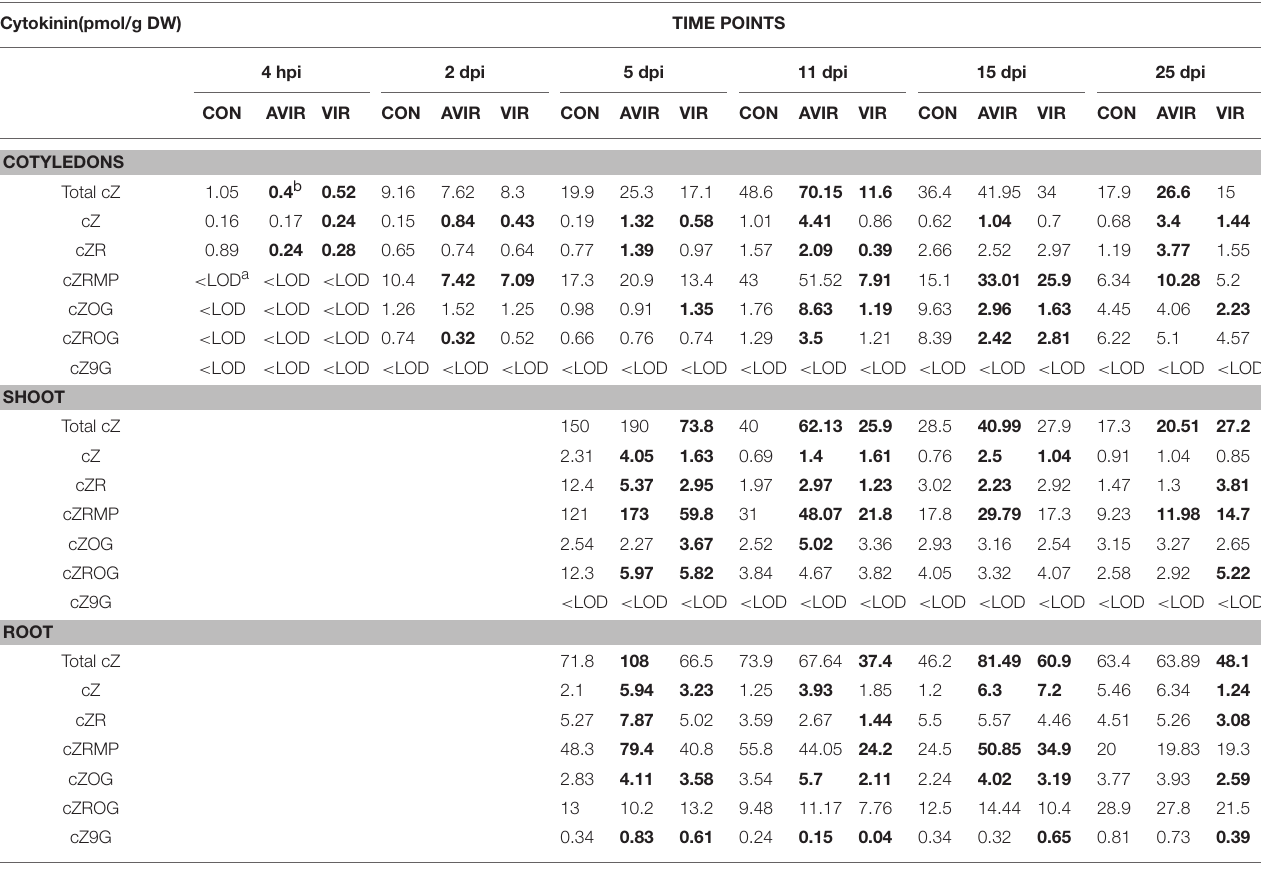
TABLE 1 | cis -cytokinin content in Pisum sativum cotyledons, shoots and roots following either mock inoculation of seeds (CON), or inoculation with avirulent strain 589 (AVIR) or virulent strain 602 (VIR) of Rhodococcus fascians . Cytokinin(pmol/g DW) TIME POINTS